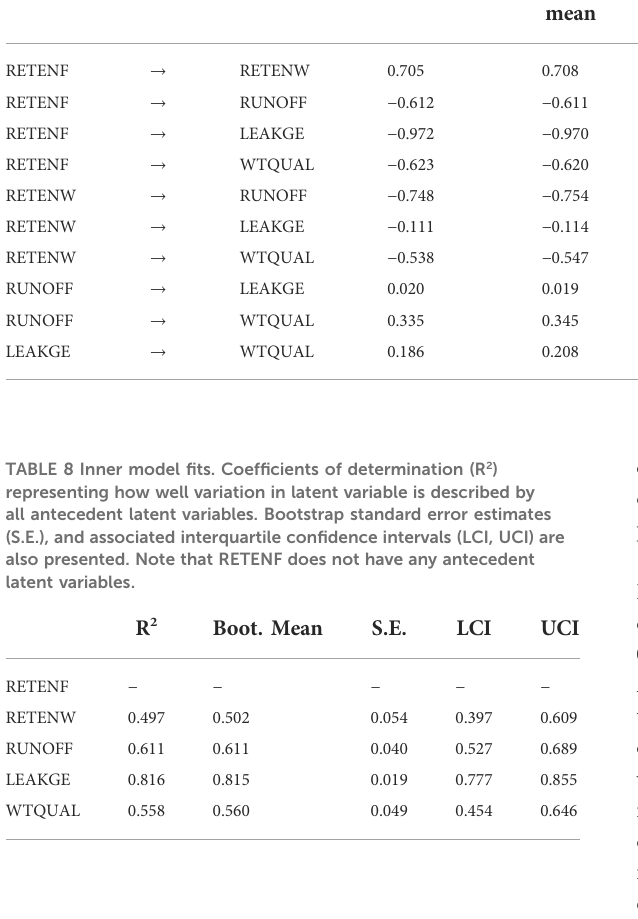
(predicted high foliar recalcitrance Figure 5C) across the Midwest.